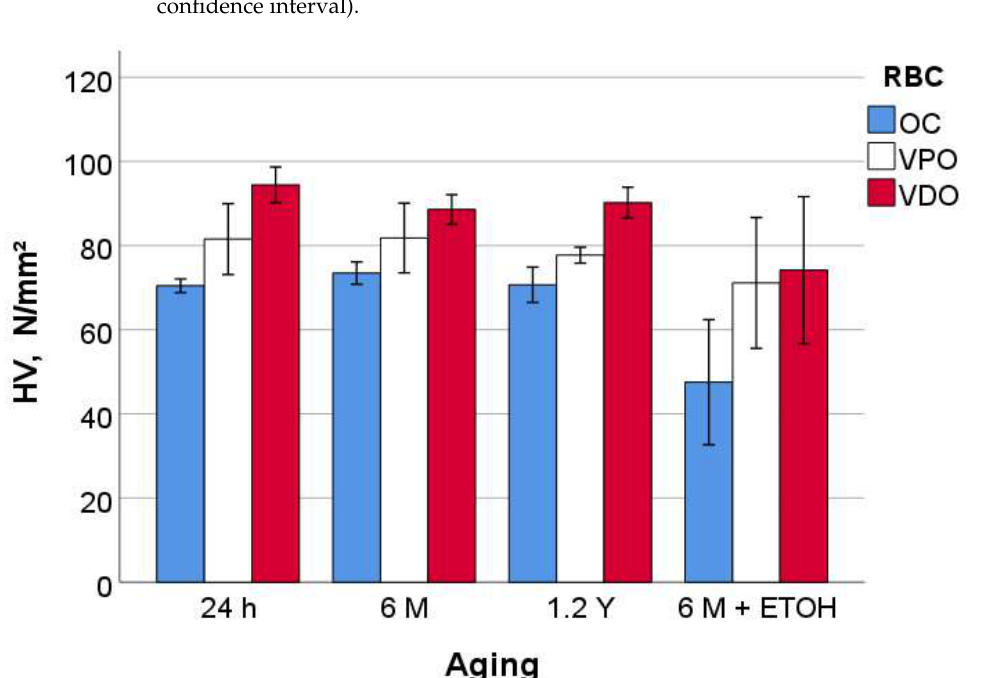
Figure 3. Vickers hardness (HV) as a function of RBC and aging method (mean values with 95% confidence interval).